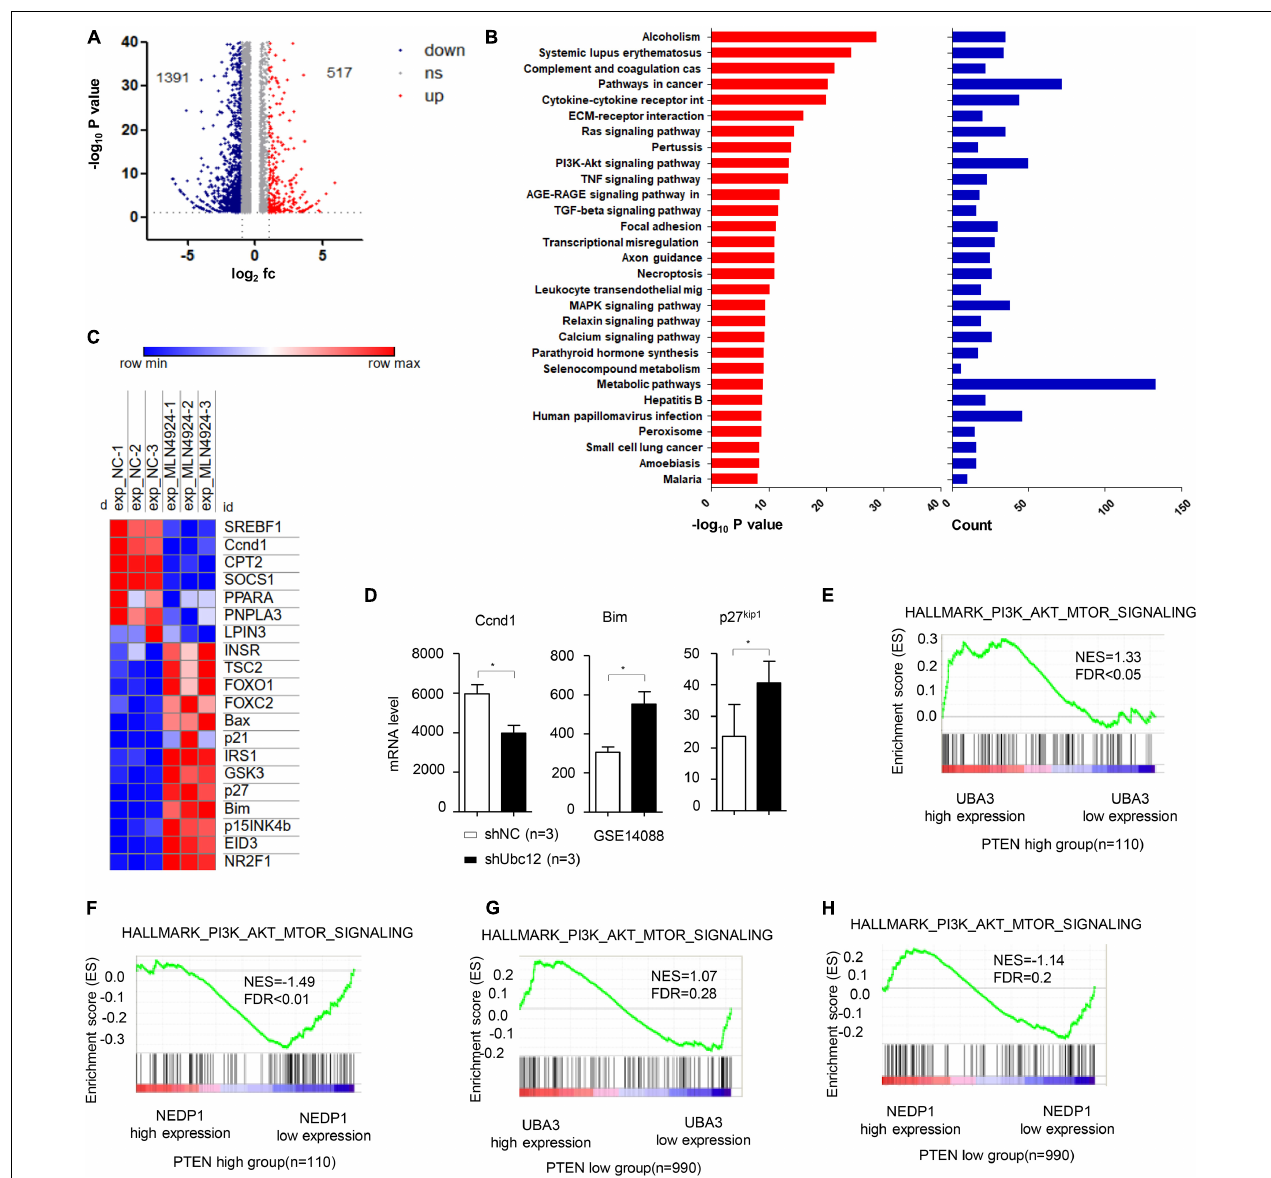
FIGURE 1 | MLN4924 inhibits the PI3K/Akt signaling pathway. (A) Differentially expressed genes in MCF-7 cells between DMSO and MLN4924 (5 µ M; 24 h) treatment groups are plotted as a volcano plot. (B) Bar charts depict the top ranked pathway analyzed from the KEGG pathway database. Blue (upper) and red (bottom) bars represent counts and significance (–log 10 P -value), respectively. (C) Heat map of the downstream target genes of Akt signaling pathway between the DMSO and MLN4924 treatment group. (D) The mRNA level of Ccnd1, Bim and p27 were analyzed in Ubc12 knockdown NIH 3T3 cells. The GEO2R online tool was used to analyze differentially expressed genes on GSE14088 microarray. * P < 0.05, ** P < 0.01, *** P < 0.001. (E,F) Enrichment plots of gene expression signatures for PI3K/Akt signaling according to UBA3 mRNA levels by gene set enrichment analysis (GSEA) of TCGA BRCA dataset in PTEN high expression group (NES = 1.33, FDR < 0.05) and PTEN low (with almost undetectable PTEN level) expression group (NES = 1.07, FDR = 0.28), respectively. Samples were divided into high and low UBA3 expression groups. False discovery rate (FDR) gives the estimated probability that a gene set with a given normalized ES (NES) represents a false-positive finding; FDR < 0.05 is a widely accepted cutoff for the identification of biologically significant gene sets. (G,H) Enrichment plots of gene expression signatures for PI3K/Akt signaling according to NEDP1 mRNA levels by gene set enrichment analysis (GSEA) of TCGA BRCA dataset in PTEN high expression group (NES =